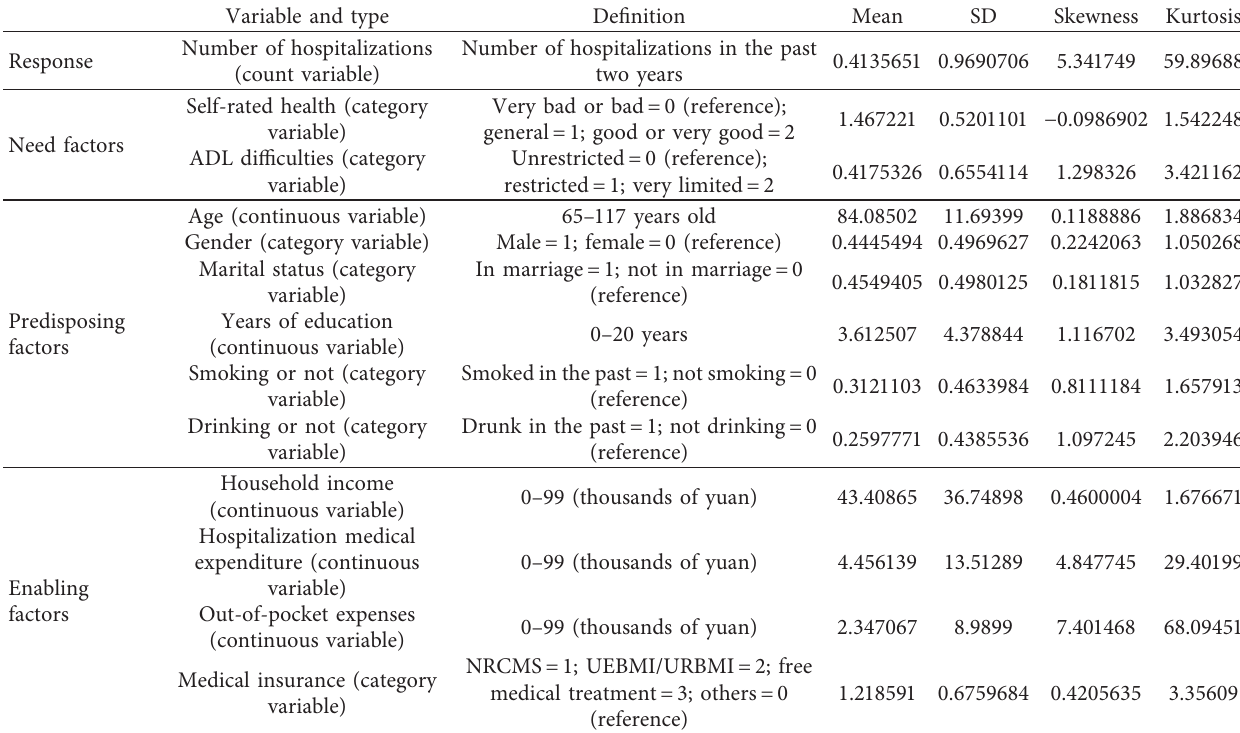
Table 1: Description of